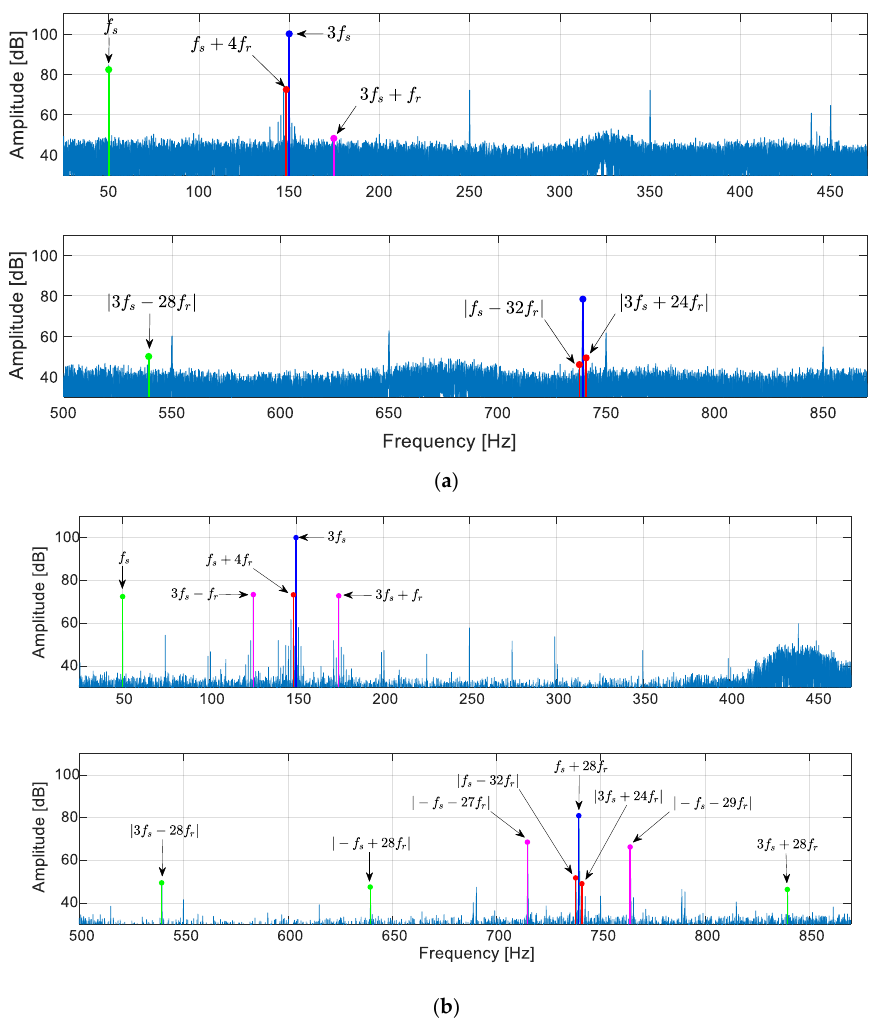
Figure 16. ZSC spectrum measured during laboratory tests of the motor with a delta winding connection; ( a ) healthy (noise level ≈ 45 dB), ( b ) rotor eccentricity (noise level ≈ 33 dB).